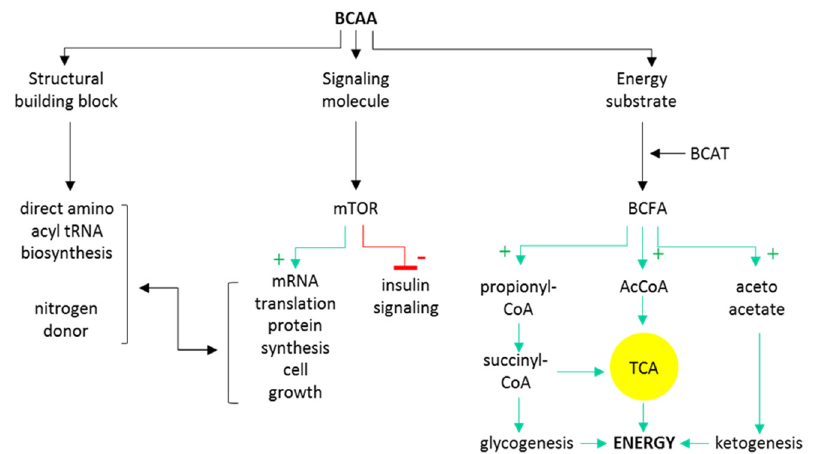
Figure 1. Schematic overview of major intracellular BCAA metabolic and signaling pathways. BCAT, branched-chain amino acid aminotransferase; BCFA, branched-chain fatty acids; AcCoA, acetyl coenzyme A; TCA, tricarboxylic acid cycle.